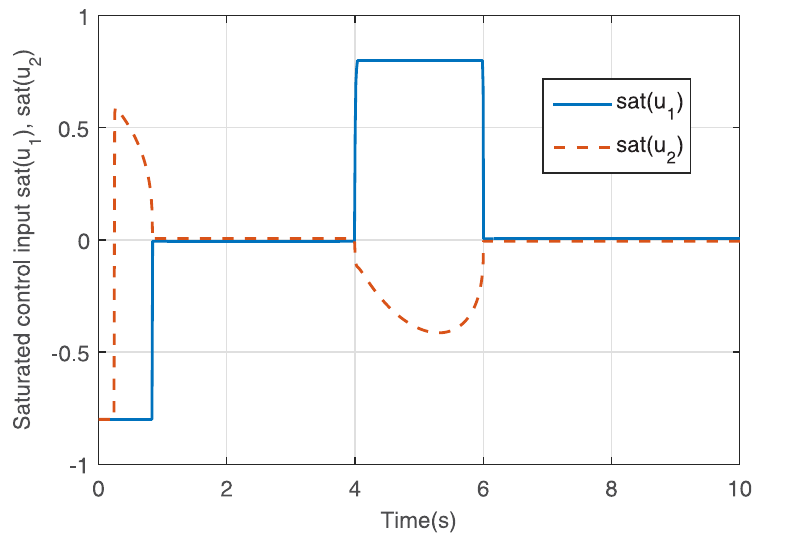
Fig 8. Response curves of the saturated control input sat ( u